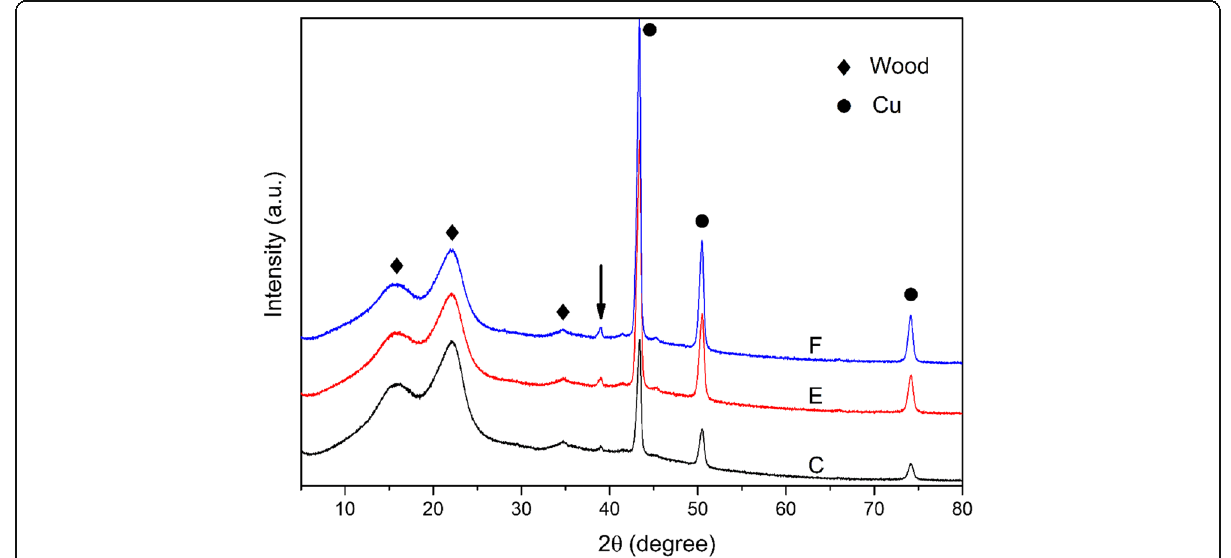
Fig. 4 XRD patterns of groups C, E, and F after 1 year stored in ambient